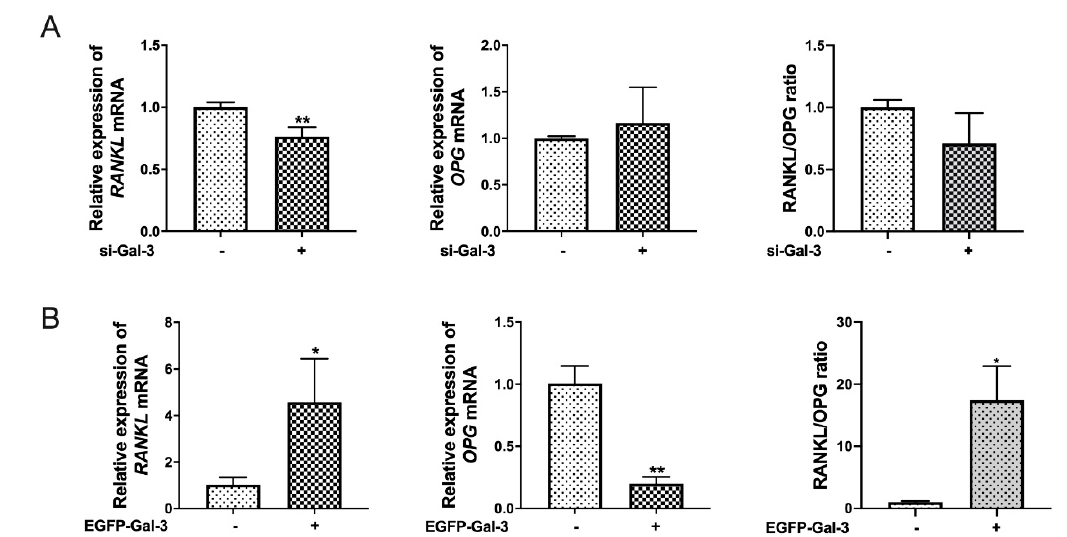
Figure 6. Gal-3 can regulate RANKL signals. ( A ) BMSCs were transfected with si-Gal-3 or NC siRNA for 10 h before being cultured in normal α -MEM for 120 h. Quantitative RT-PCR was used to measure RANKL and OPG mRNA levels to analyze the RANKL/OPG ratio ( n = 3 per group). ( B ) BMSCs were transfected with EGFP-Gal-3 or EGFP empty plasmid for 10 h before being cultured in normal α -MEM for 120 h. Quantitative RT-PCR was used to measure RANKL and OPG mRNA levels to analyze the RANKL/OPG ratio ( n = 3 per group). (Graph bars show mean ± SD. * p < 0.05 and ** p < 0.01 show significant difference compared with the control group).